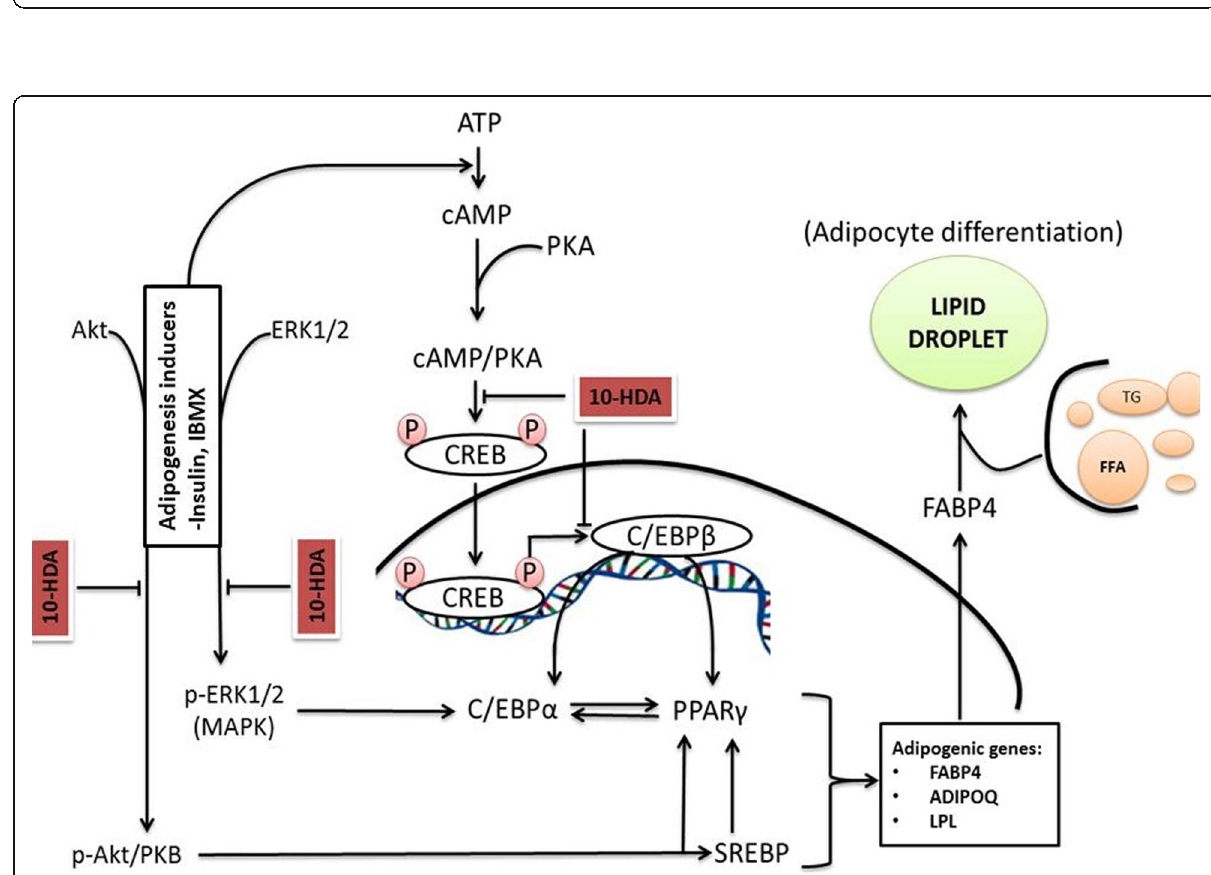
Fig. 8 Schematic diagram on the molecular mechanism of the anti-adipogenic effect of 10-HDA in 3 T3-L1 preadipocytes. 10-HDA inhibited the accumulation of lipid droplets within 3 T3-L1 adipocyte via two possible mechanisms; by inhibiting cAMP/PKA pathway and p-Akt and MAPK dependent insulin signaling pathway. ATP: adenosine triphosphate; PKA: protein kinase A; MAPK: mitogen-activated protein kinase; ADIPOQ: adiponectin precursor gene; LPL: lipoprotein lipase; FFA: free fatty acids; TG: